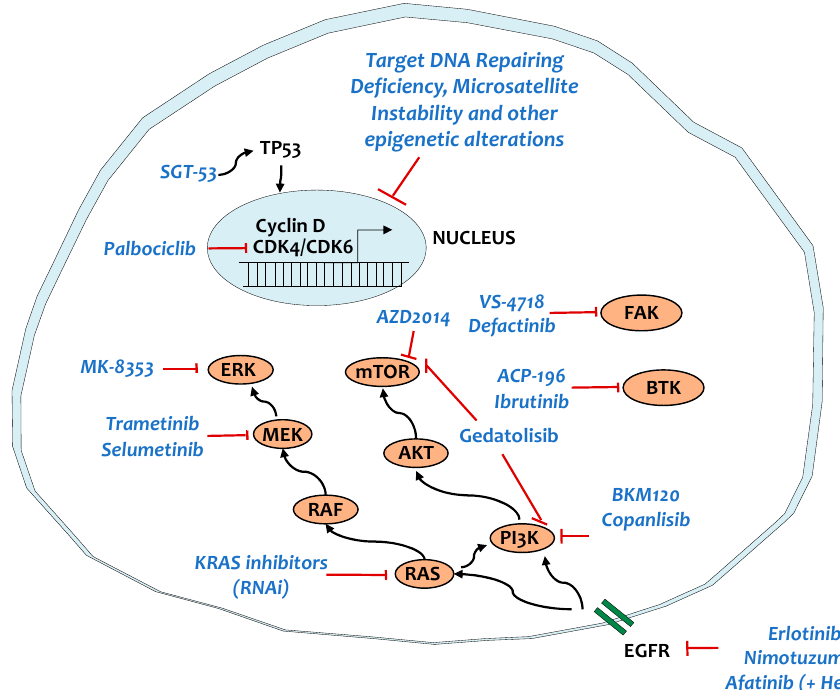
Figure 1. Targeting key signaling pathways in patients with pancreatic ductal adenocarcinoma (PCa). EGFR, epidermal growth factor receptor; RAS, rat sarcoma viral oncogene; AKT, protein kinase B; CDK4/CDK6, cyclin-dependent kinase 4/6; RAF, rapidly accelerated fibrosarcoma; MEK, mitogen-activated protein kinase; ERK, extracellular signal-regulated kinases; PI3K, phosphoinositide 3-kinase; mTOR, mechanistic target of rapamycin; FAK, focal adhesion kinase; BTK, Bruton’s tyrosine kinase.